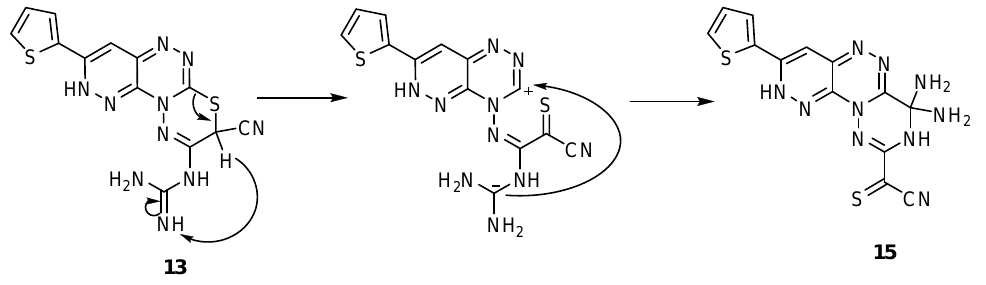
Scheme 4. The mechanism of formation of compound 15 .